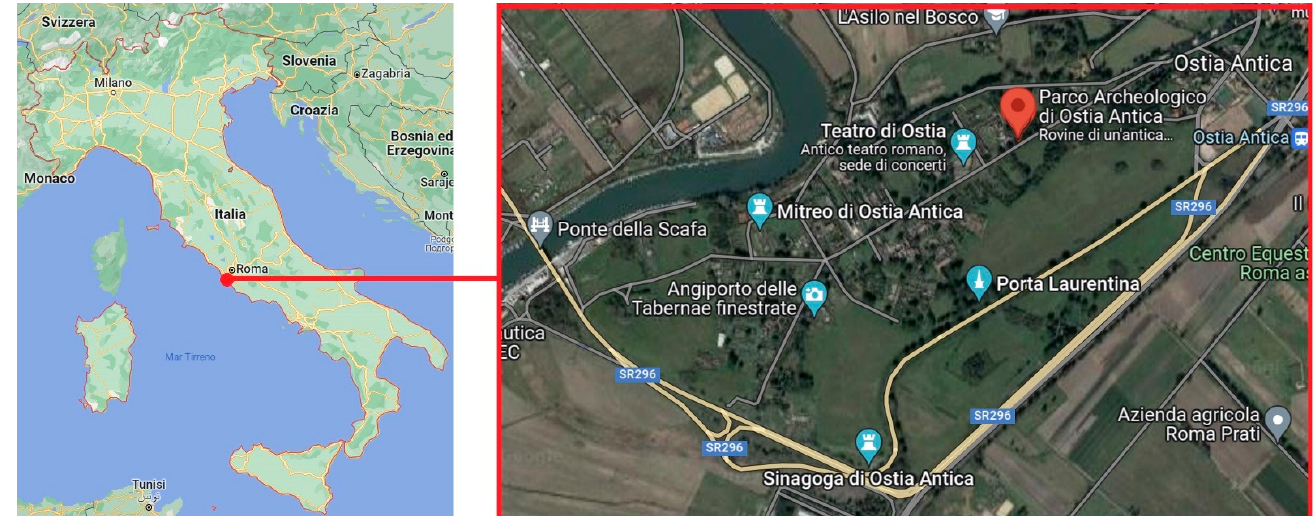
Figure 1. Map of Italy indicating the location of Ostia Antica.